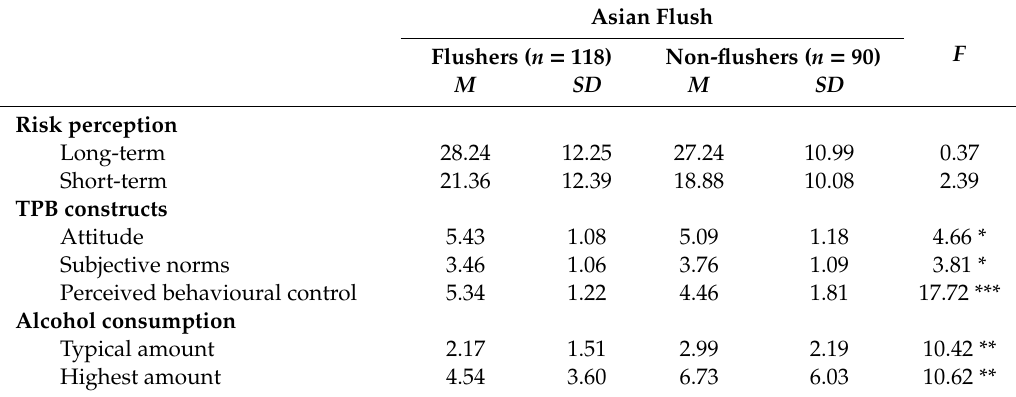
Table 3. Risk Perceptions, TPB Constructs and Alcohol Consumption by Asian